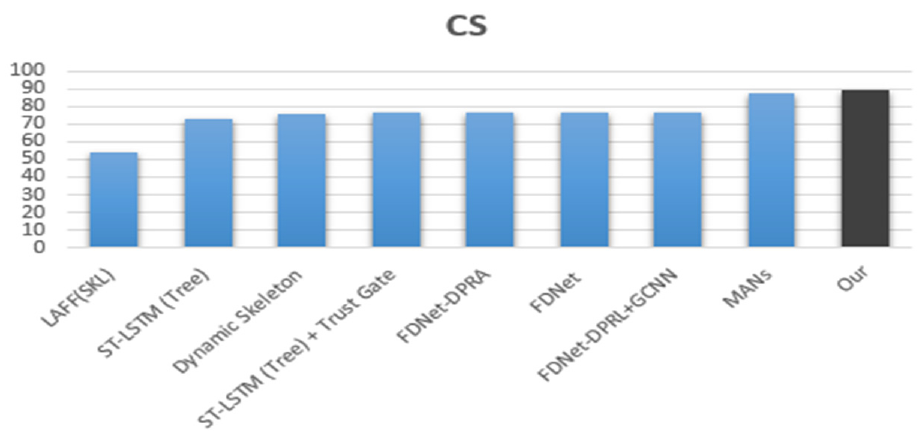
Figure 6. Accuracy comparisons for cross-subject (CS) evaluation for different methods using the SYSU dataset.